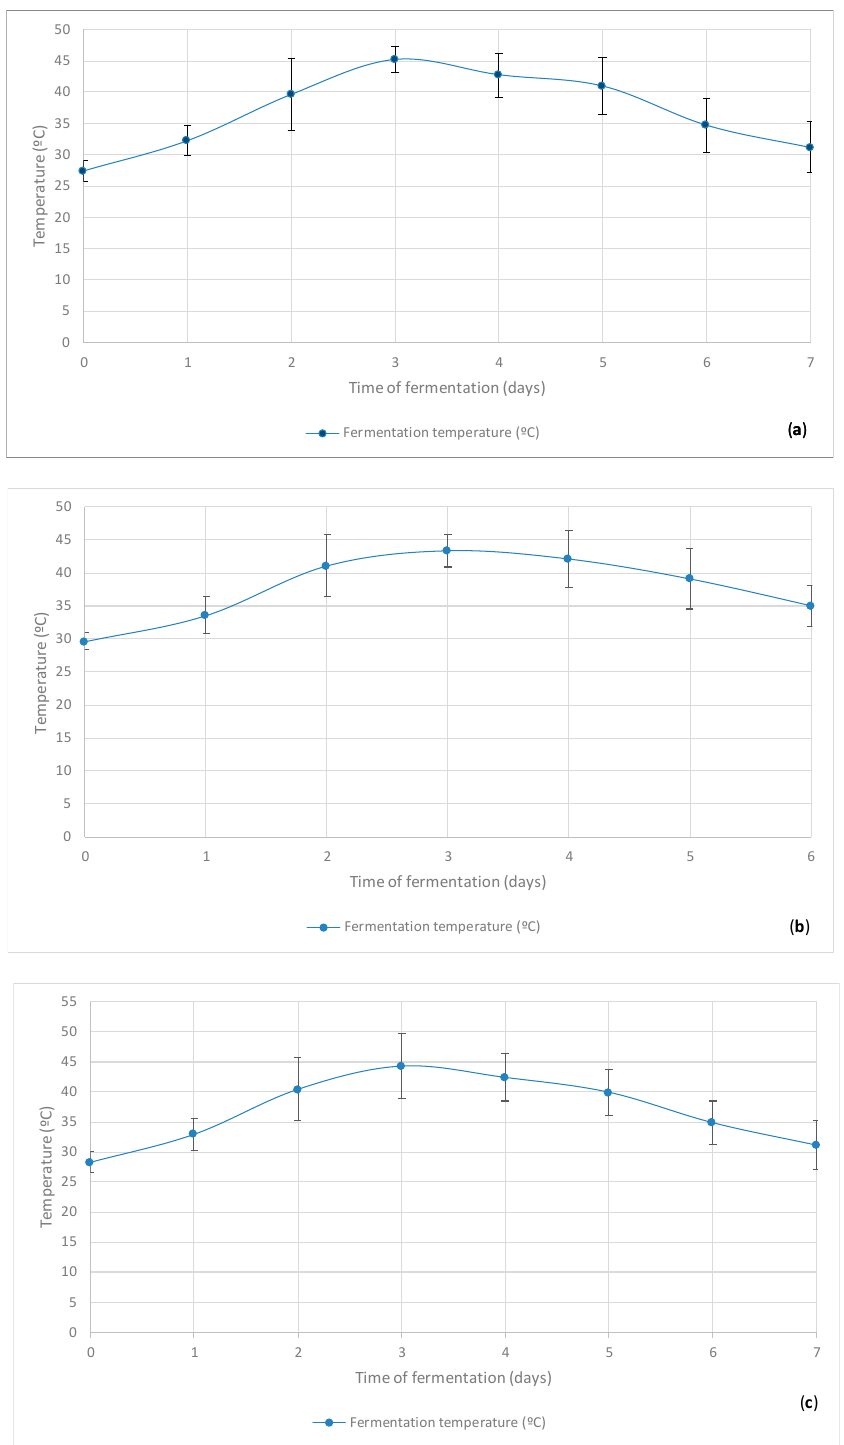
Figure 5. Average values and standard deviations (mean ± STDV) from 3 analytical measures per batches (lot) of 5 lots and 2 sampling periods per each day (morning and afternoon), for the temperature parameters of the seeds throughout 6–7 days of controlled fermentation of cupuaçu seeds : ( a ) average in morning; ( b ) average in afternoon; and ( c ) overall average (morning and afternoon). The initial, after fermentation, and after drying weights were, respectively: 100.0, 77.65, and 37.65 kg in lot 1; 100.0, 83.0, and 41.8 kg in lot 2; 100.0, 81.0, and 39.2 kg in lot 3; 100.0, 103.0, and 53.3 in lot 4; and 100.0, 82.0, and 39.5 in lot 5.